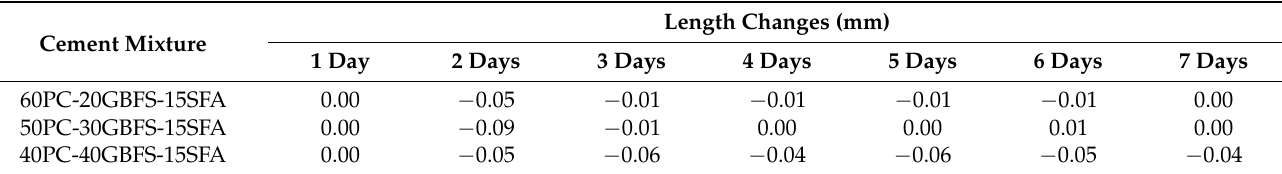
Table 4. Length changes of the cement paste prismatic